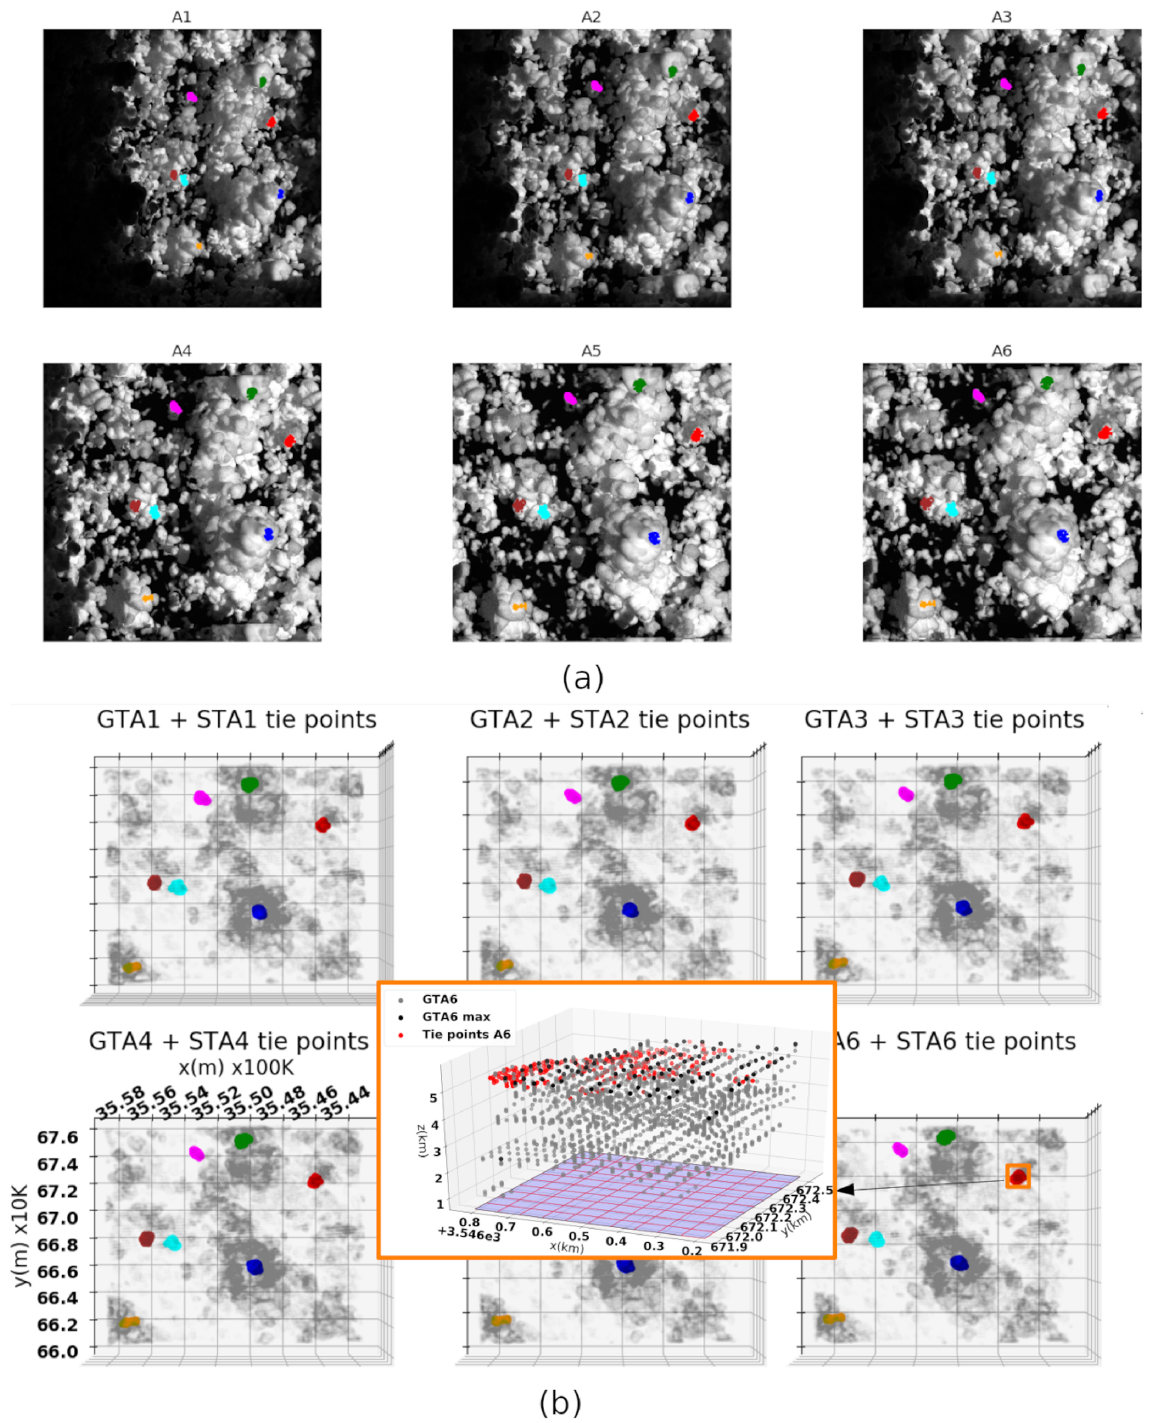
Figure 13. (a) Image tie points tracked from simulations A1 to A6 via MGM. Each group of points is associated with a given colour. (b) ST tie points from panel (a) in 3D space and GT point clouds from A1 to A6. Zoomed-in inset showing the atmospheric columns for point selection from the GT point